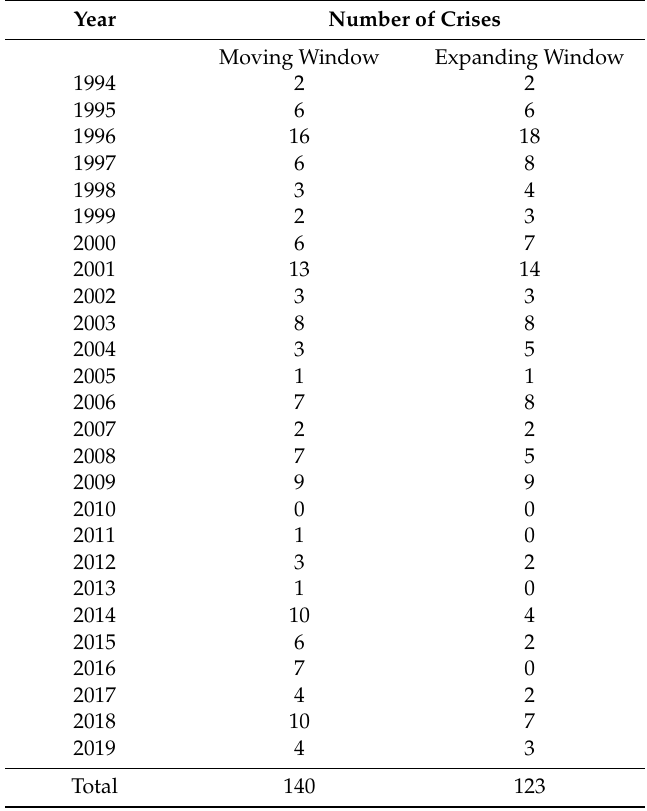
Table 4. Crisis events in the US natural gas